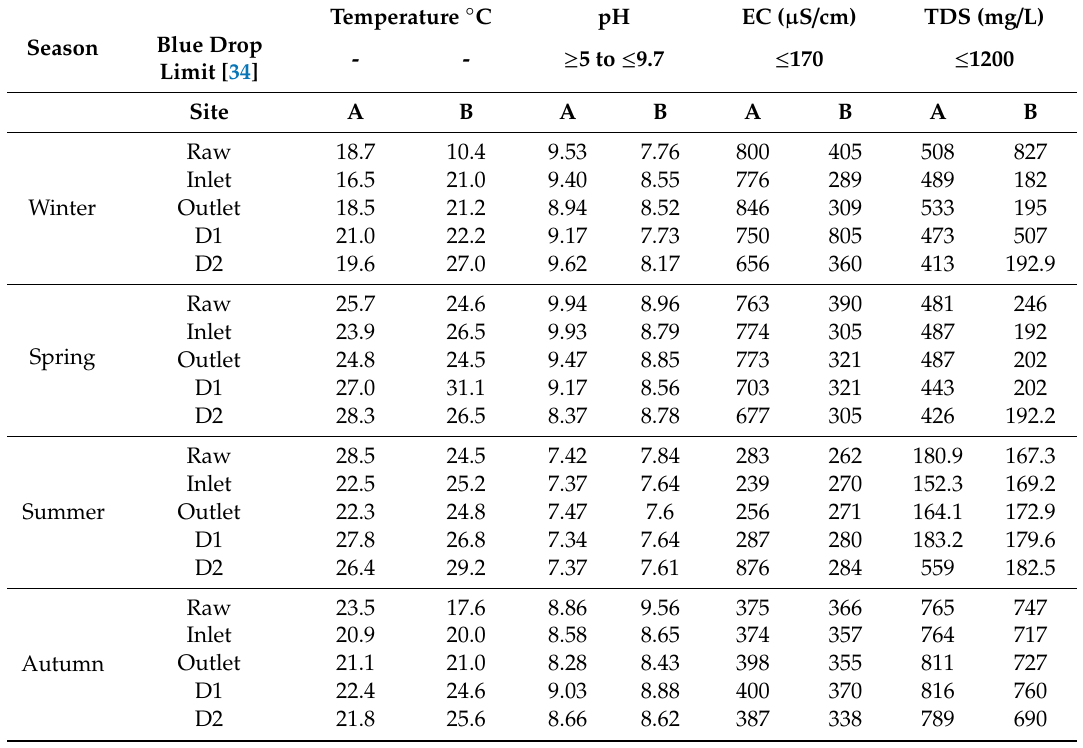
Table 1. Mean physicochemical parameters from sites A and B throughout the sampling period.